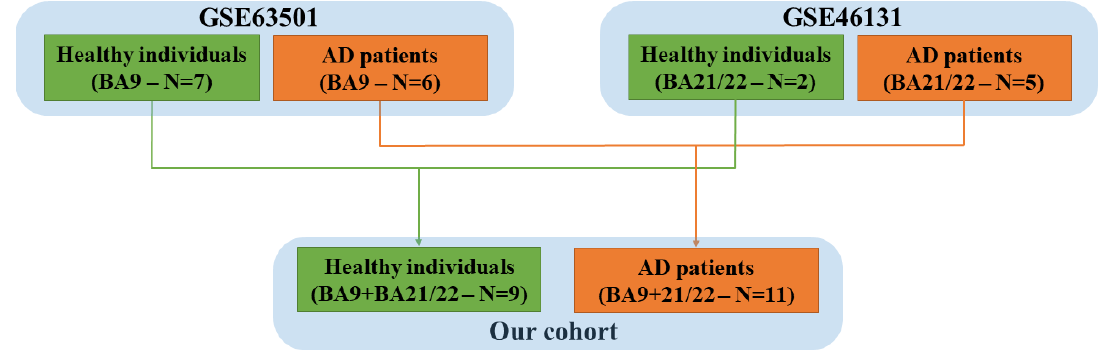
Figure 2. Our analysis was carried out on 9 healthy individuals (N = 7 GSE63501 and N = 2 GSE46131) and 11 Alzheimer’s disease (AD) patients (N = 6 GSE63501 and N = 5 GSE46131). GSE: Gene Series